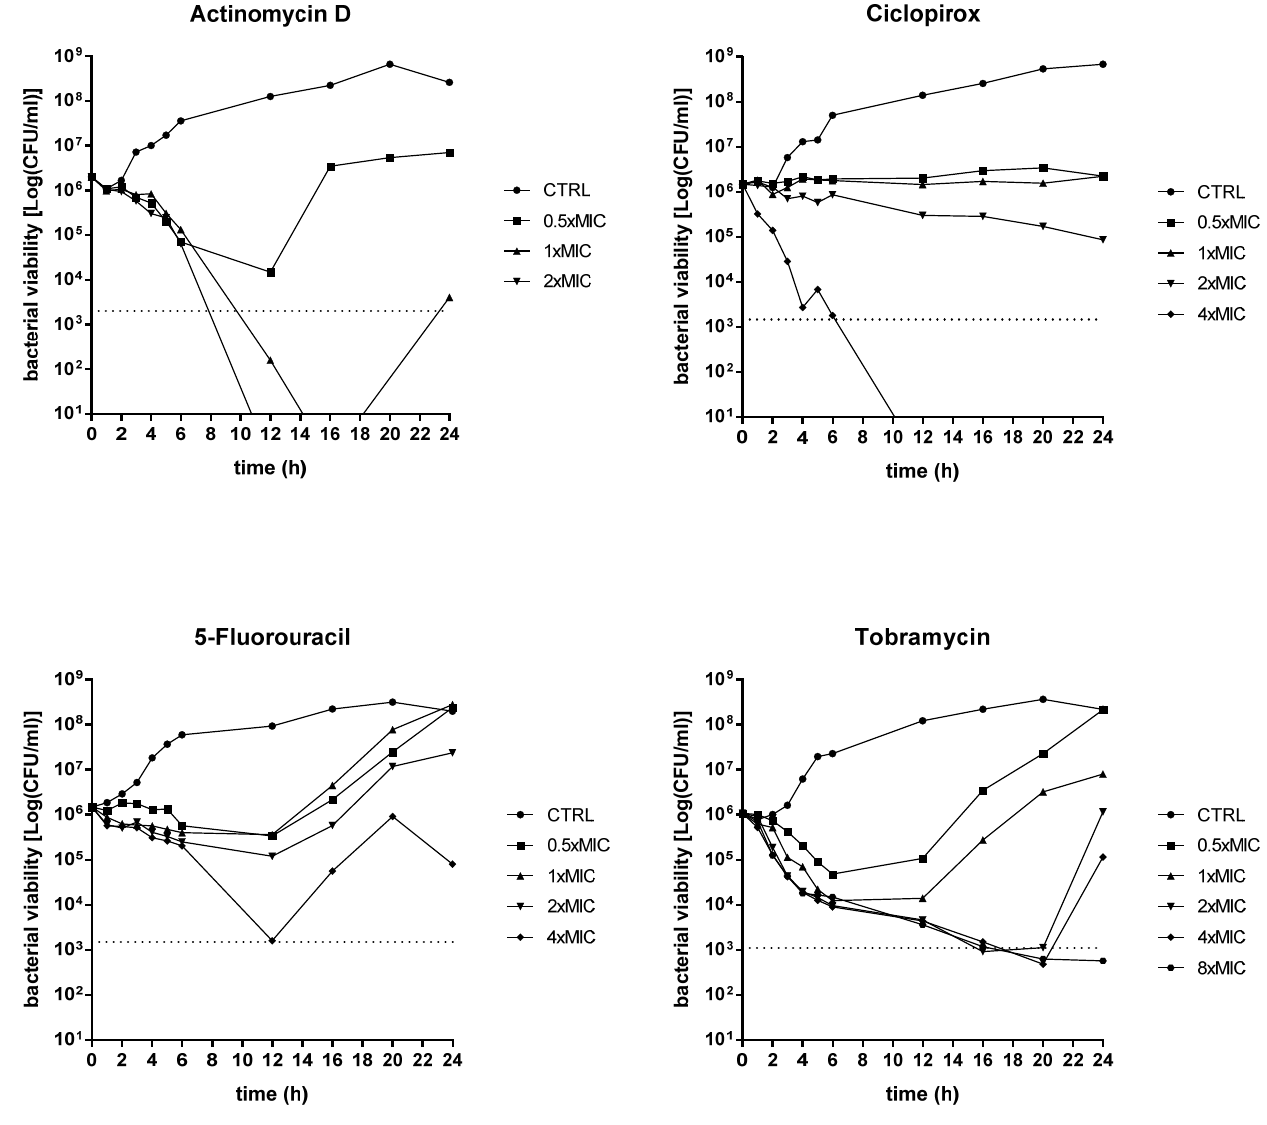
Figure 2. Time–kill kinetics against P. aeruginosa PaPh32. The kinetics of repurposed drugs was assessed, comparatively to tobramycin, over 24 h in a liquid medium. P. aeruginosa PaPh32 was chosen as representative of tobramycin-resistant strains. Each drug was tested at MIC value (actinomycin D: 133 mg/L; ciclopirox: 256 mg/L; 5-fluorouracil: 512 mg/L; tobramycin: 64 mg/L), its fractions and multiples, compatibly with the drugs’ solubility. The dotted line indicates bactericidal activity, defined as a ≥ 3 Log (CFU/mL) reduction of the initial inoculum size. The limit of detection was 10